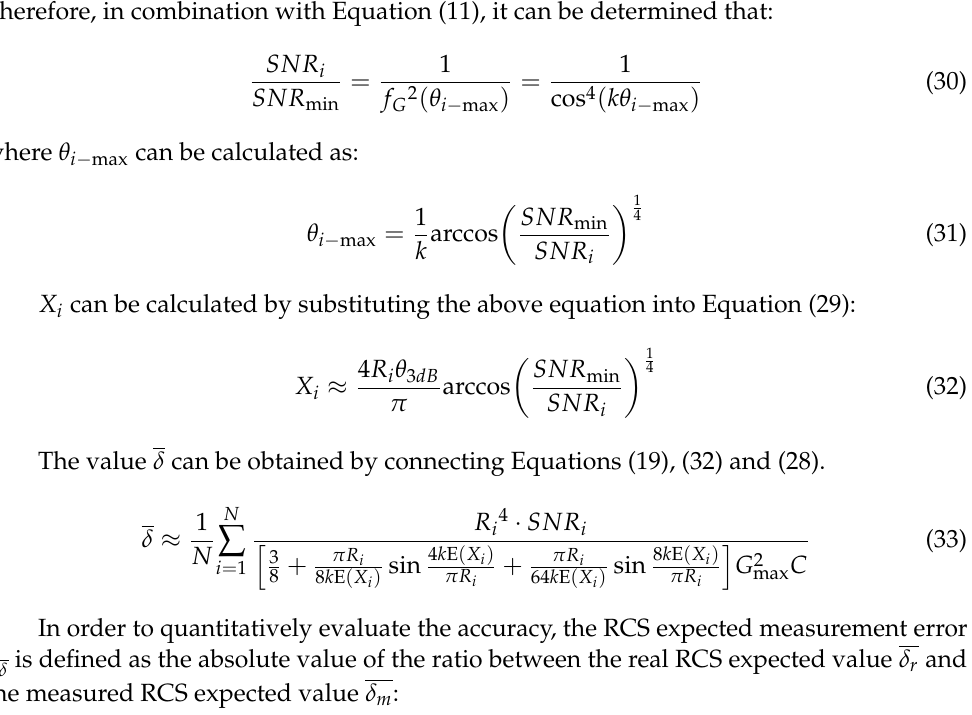
θ Figure 6. Relation curve between the target SNR and when the insect crosses the beam. Figure 6. Relation curve between the target SNR and θ when the insect crosses the beam. SNR is the detection threshold, which is usually set as a constant. In Figure 6, In Figure 6, SNR min is the detection threshold, which is usually set as a min